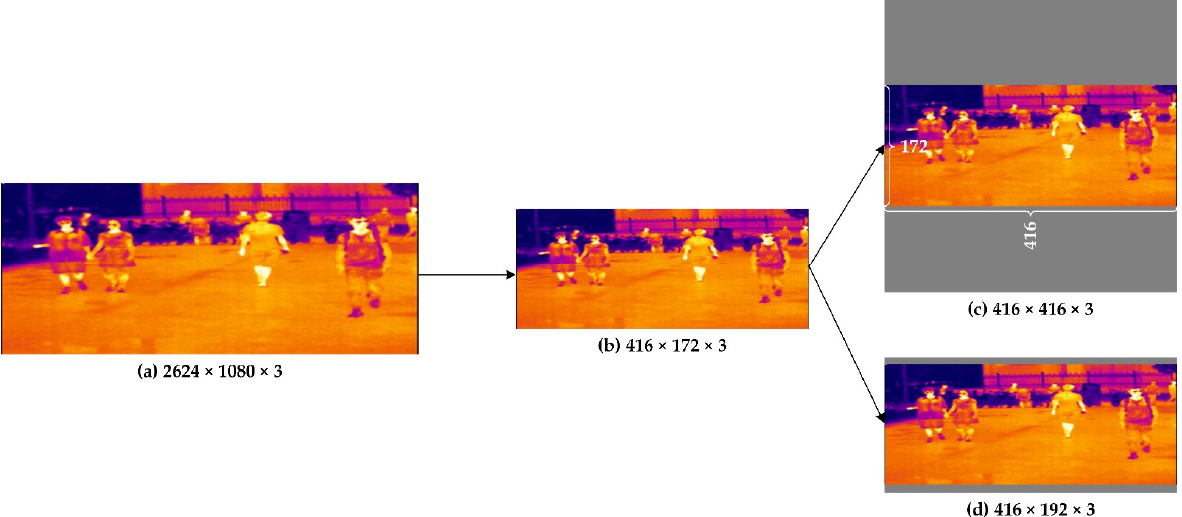
Figure 1. The input image is undistorted. ( a ) the original image; ( b ) the resized image; ( c ) the gray-filled image with a data dimension of 416 × 416 × 3; and ( d ) the gray-filled image with a data dimension of 416 × 192 × 3.